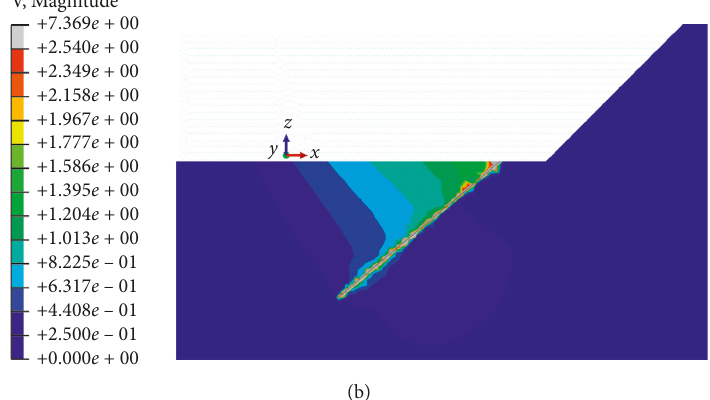
Figure 10: Contours of vibration velocity of 2 ms blasting under different explosive densities. Blasting load: (a) 1620MPa and (b) 1296MPa.